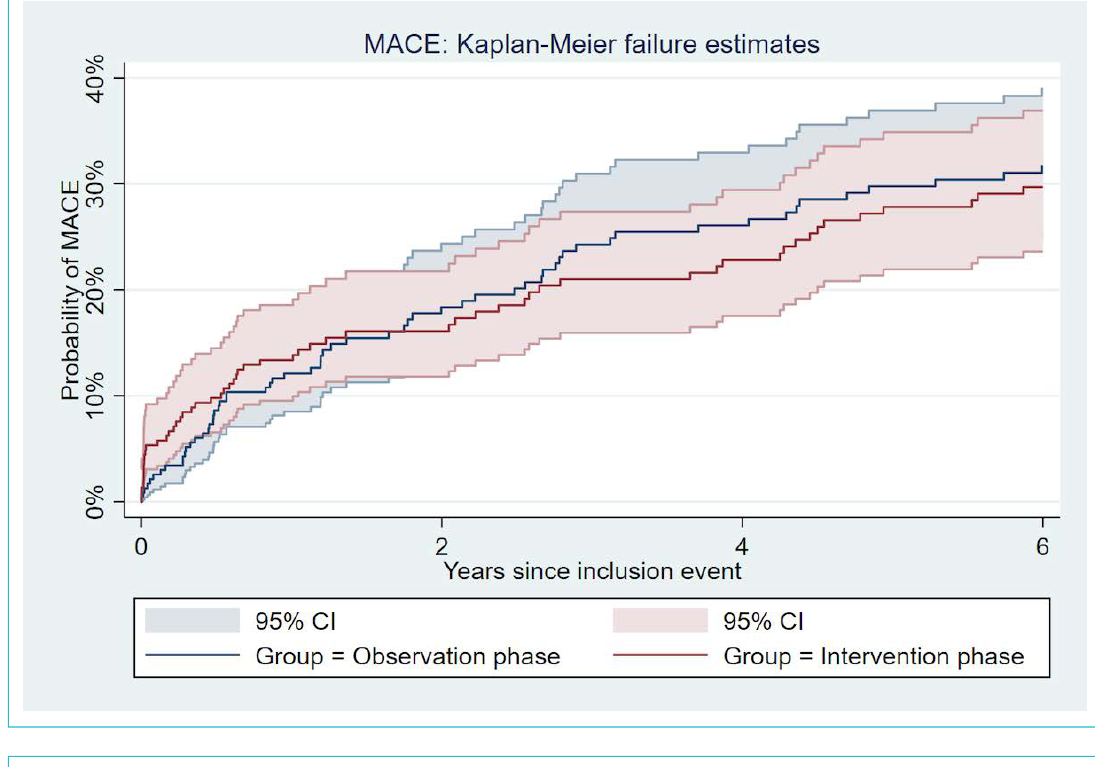
Figure 1: Incidence of Major adverse cardiovascular event 5 years after an acute coronary syndrome, by study phase.